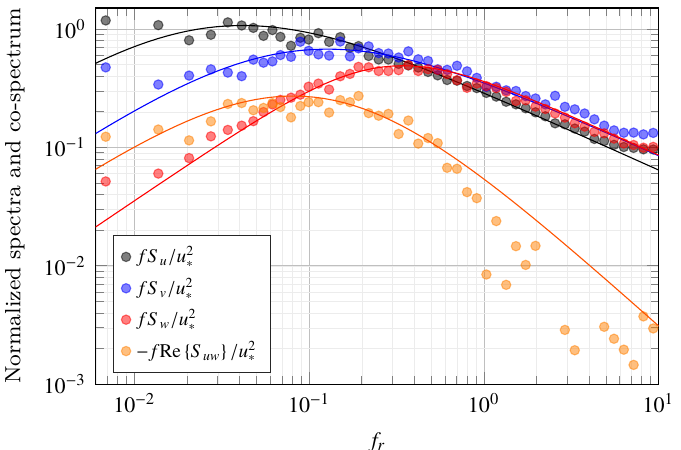
Figure 4. Estimated (scatter) and fitted (solid lines) one-point auto- and cross-power spectral estimates at z = 49 m above ground from 2:00 a.m. to 5:00 a.m. on 8 December 2017. Table 3. Spectral parameters from Equations (1)–(3) and (7) estimated using wind data recorded from 2:00 a.m. to 5:00 a.m. on 8 December 2017 on MW1. Coefficients a u a v a w a uw b uw Values 118 24 3.6 12